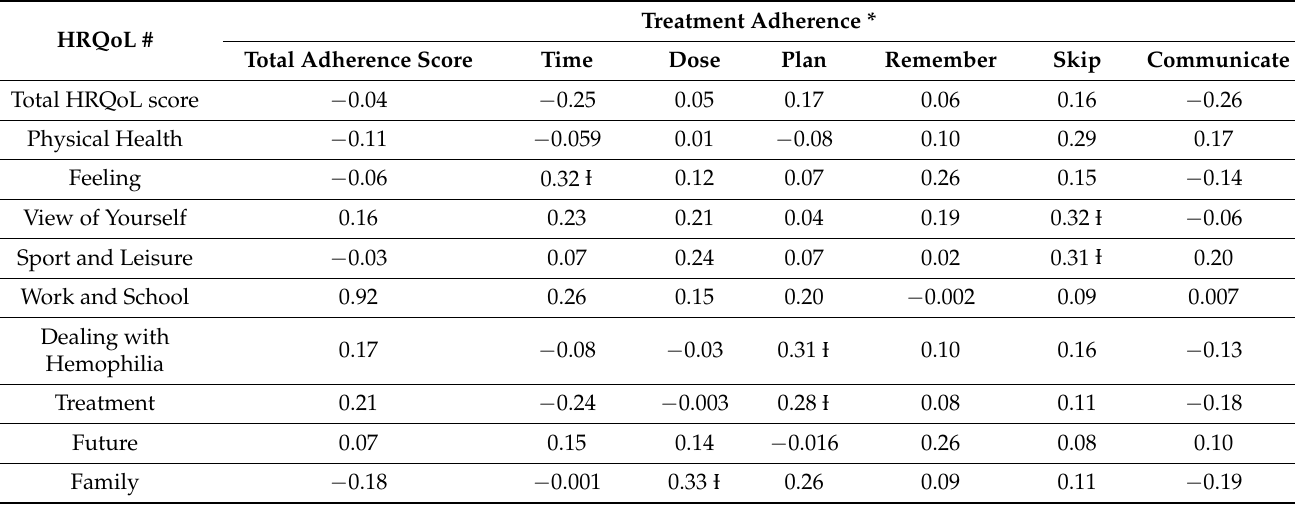
Table 4. Correlation between Treatment Adherence and Health-related Quality of Life Outcomes.